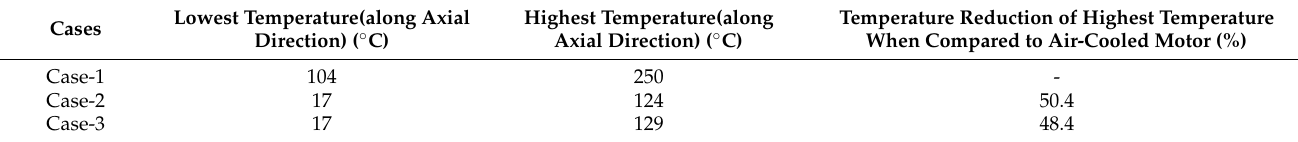
Table 18. Temperature reduction for Case-2 and Case-3 when compared to air-cooled motor (Case-1).